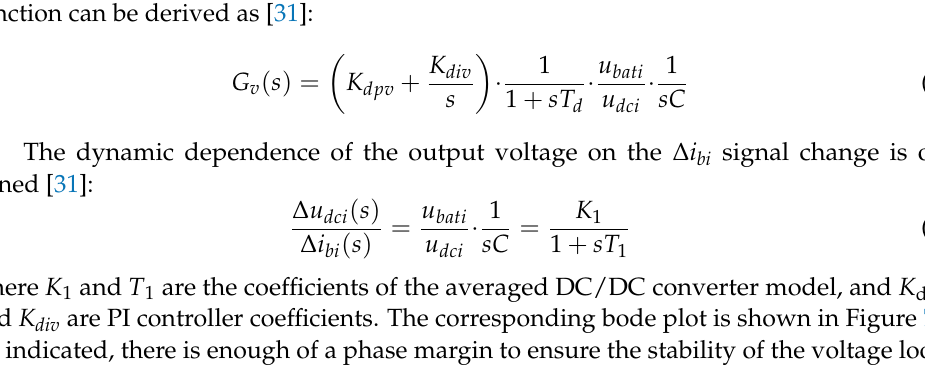
Figure 6. Control loop modelling of DC/DC converter.